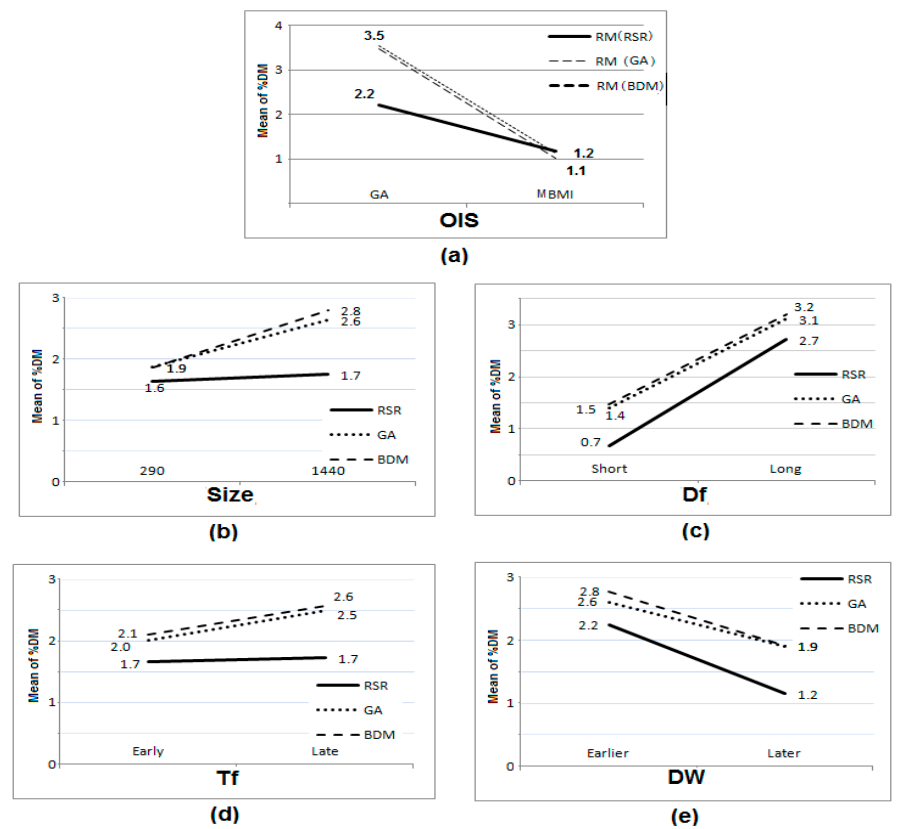
Figure 8. Interaction effect of factors with RM on mean %DM, where ( a ) interaction of RM x OIS ( b ) interaction of RM x Size ( c ) interaction of RM x D f ( d ) interaction of RM x T f and ( e ) interaction of RM vs DW.